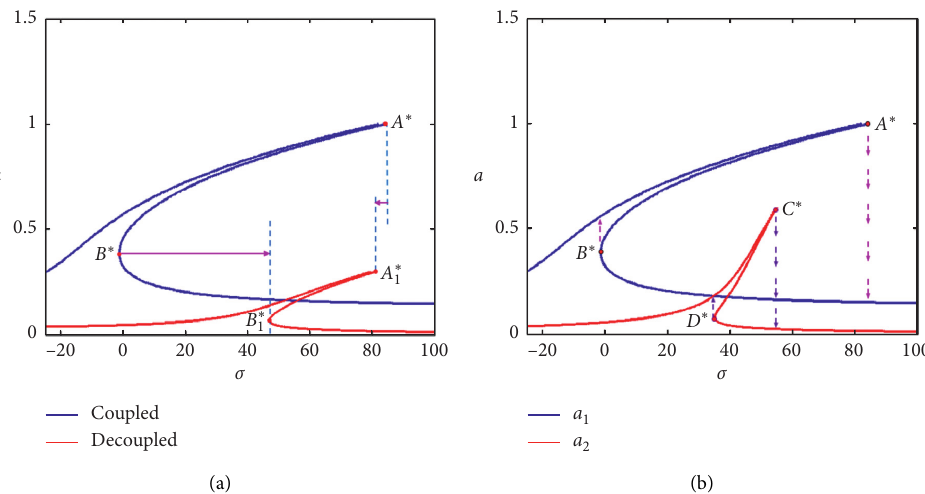
Figure 3: The amplitude-frequency response curves of the cantilevered pipe conveying pulsating fluid are obtained when flow velocity is U � 1 . 5 and external force is F � 2 . 5. (a) Coupling influence on amplitude-frequency response curves; (b) amplitude-frequency response 0 curves of the first-order and third-order